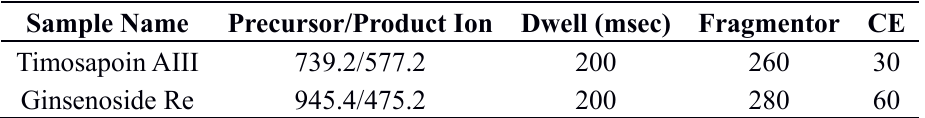
Table 2. Optimized multiple-reaction monitoring (MRM) parameters for Timosapoin AIII and ginsenoside Re